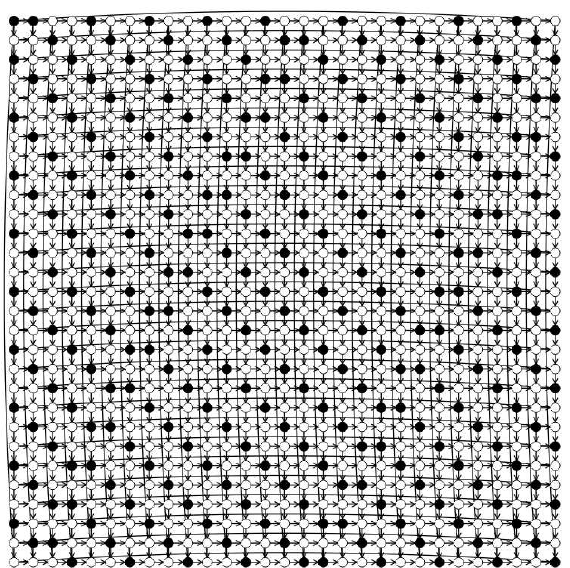
Figure 2. A dominating set with 290 vertices in C 29 (cid:3) C 29 .